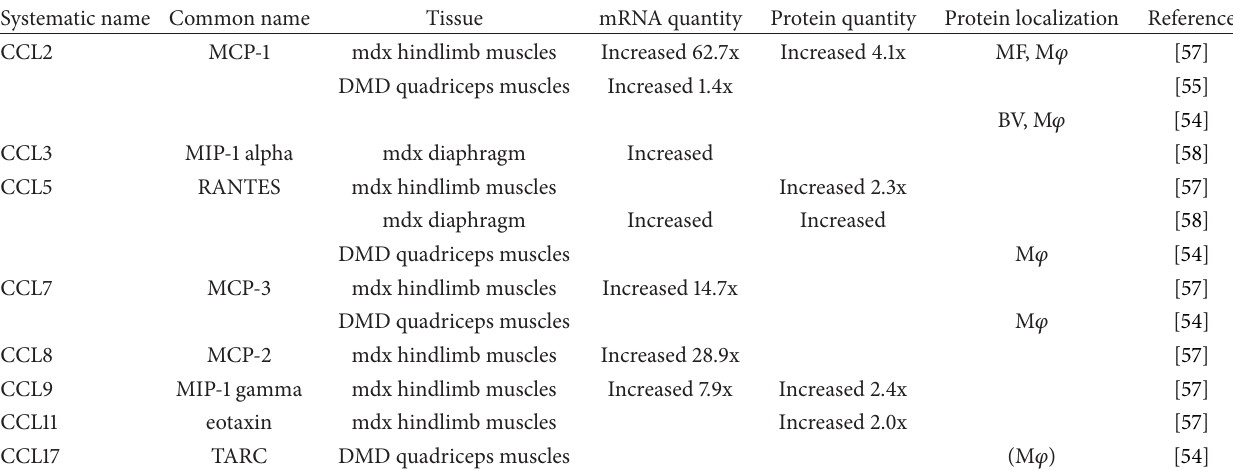
Table 2: Beta-chemokine expression in Duchenne muscular dystrophy and its mouse